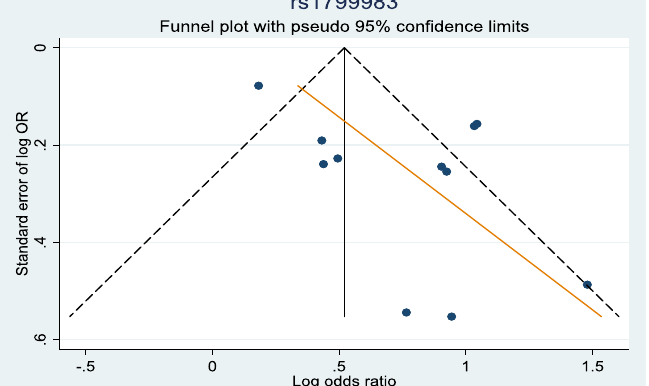
Figure 4 . Funnel plot for the rs1799983. Egger’s test, p=0.043. Begg’s test, p=0.586. Based on Egger’s test, there was a publication